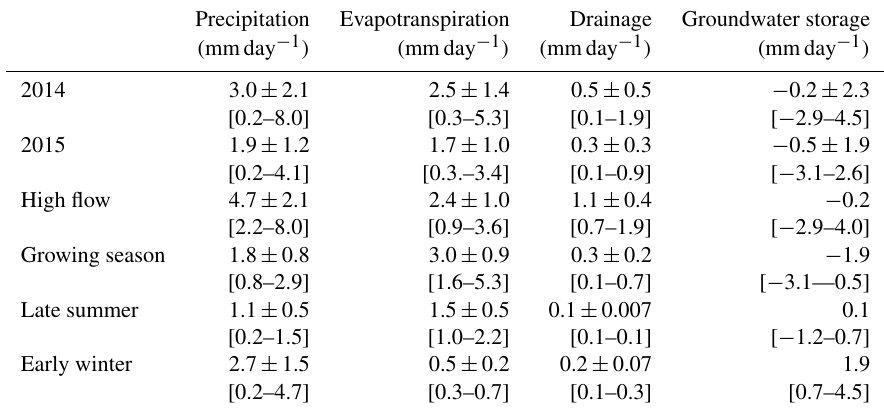
Table 1. Water budget on the Bilos plot scale for the years 2014 and 2015, as well as for high flow (January–March 2014 and February– 2015) and early winter (November 2014–January 2015 and November–December 2015). Numbers represent the mean ± SD and the range (in square